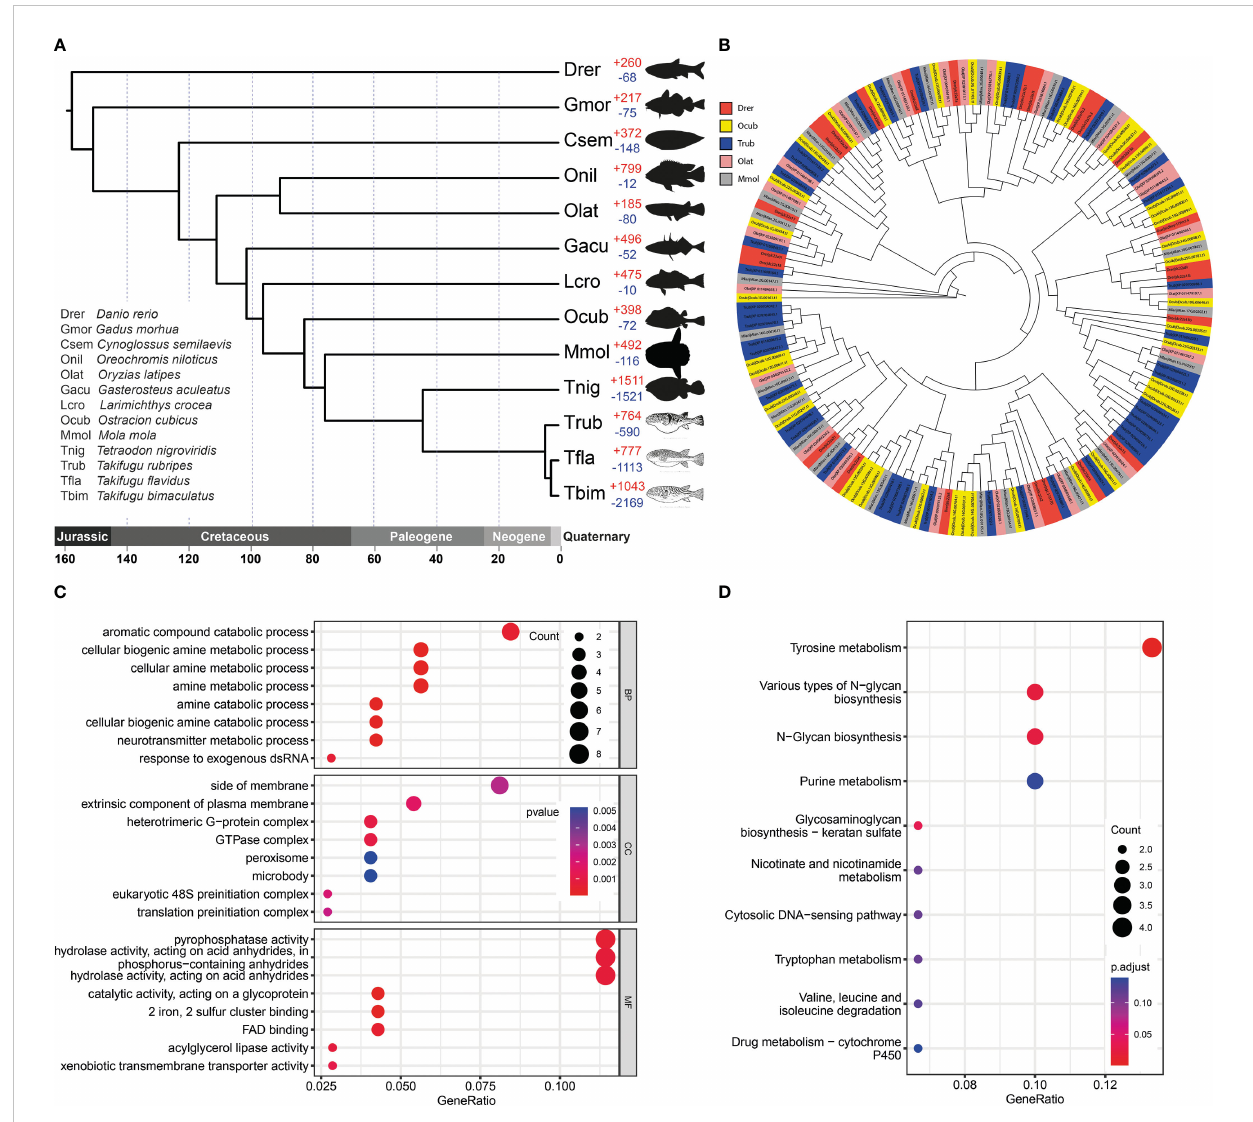
FIGURE 3 Gene family evolution and thesolute carrier family 22 gene clusters comparison. (A) Phylogenetic analysis of O. cubicus within the Clupeocephala lineage and gene family gain-and-loss analysis, including the number of gained gene families (+) and lost gene families (-). Abbreviations corresponding to the Latin name of species were listed in the bottom left corner. (B) The phylogeny of the solute carrier family 22 in ray fi nned fi shes. Drer, Ocub, Trub, Olat and Mmol are presented in the zebra fi sh, yellow box fi sh, fugu, medaka and sun fi sh, respectively. (C) GO enrichment analysis of expanded gene families. (D) KEGG enrichment analysis of expanded gene